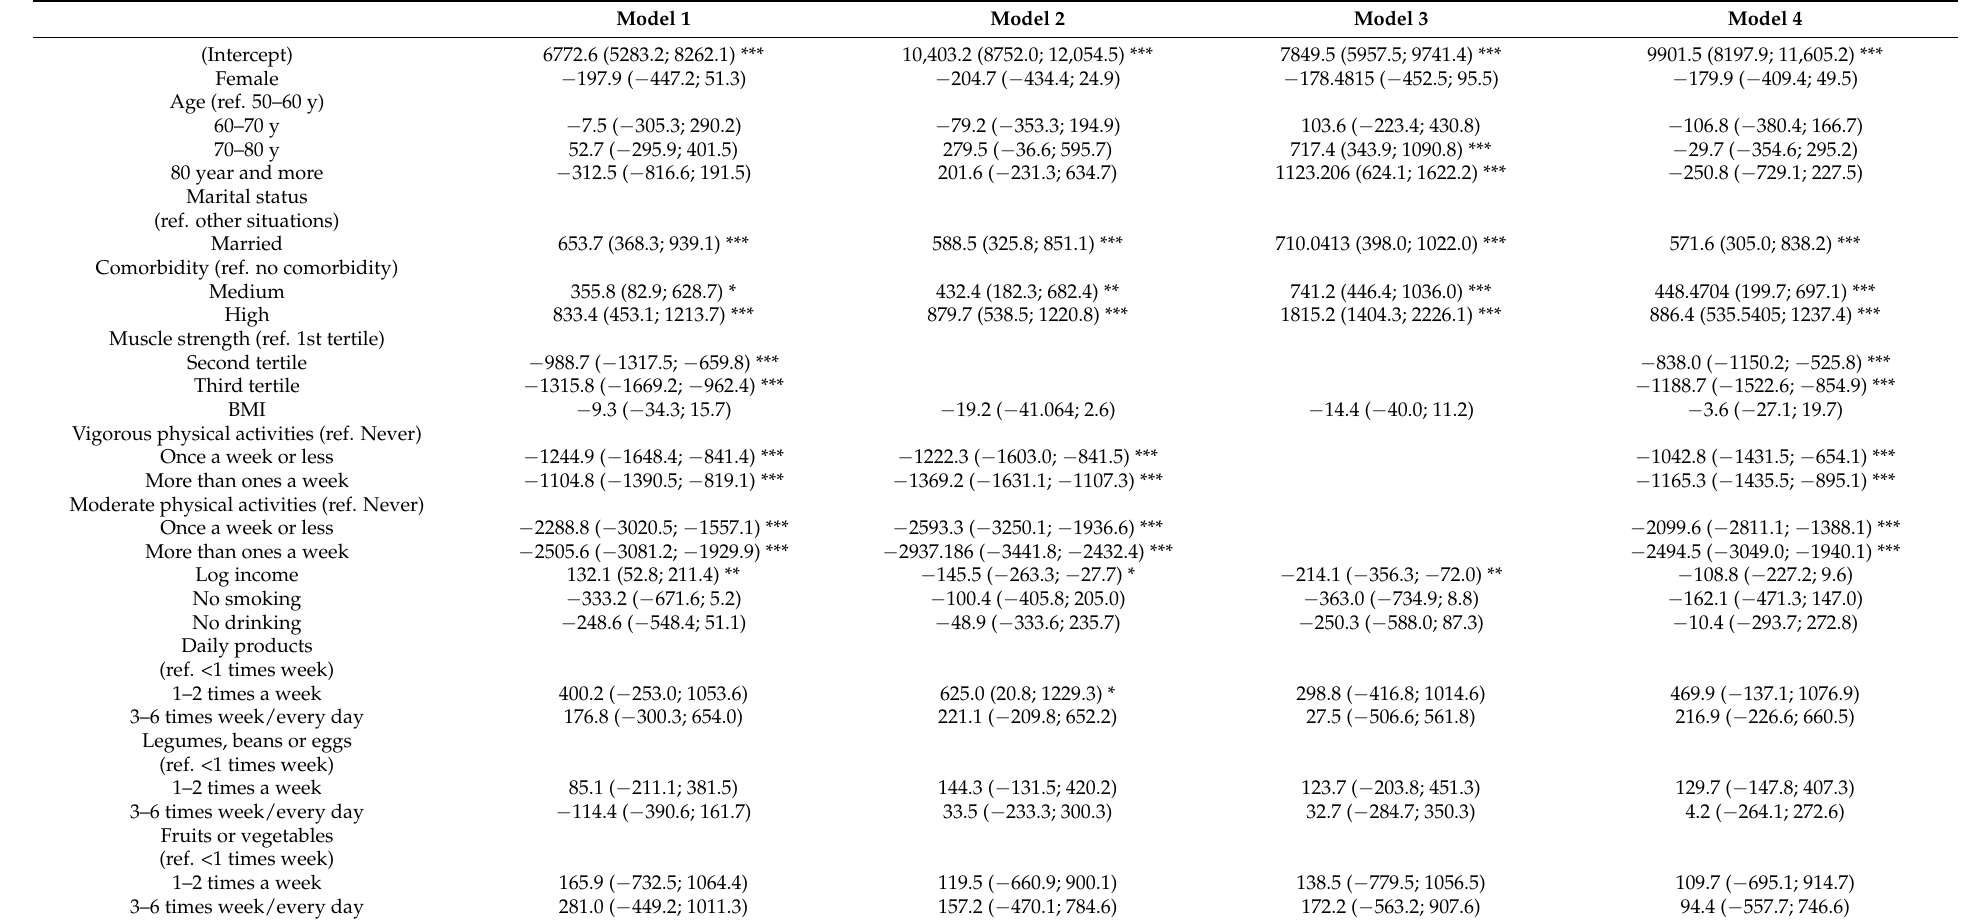
Table 4. Panel Estimators of hospitalization costs for Generalized Linear Models with gamma